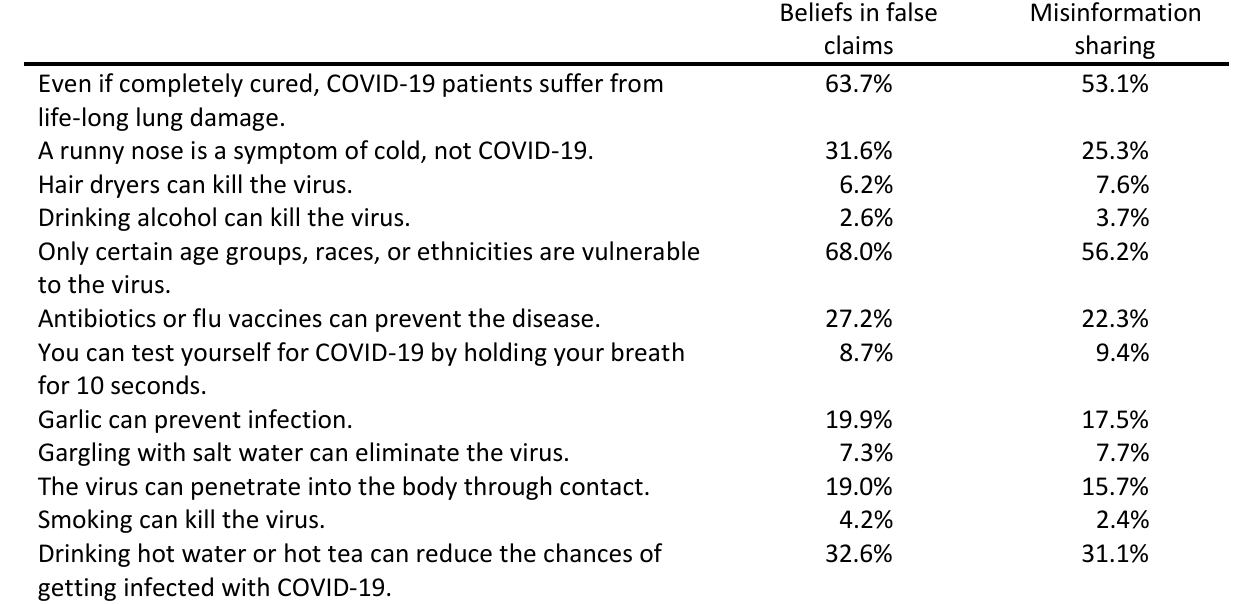
Table 2. Twelve false claims about COVID-19 (N =